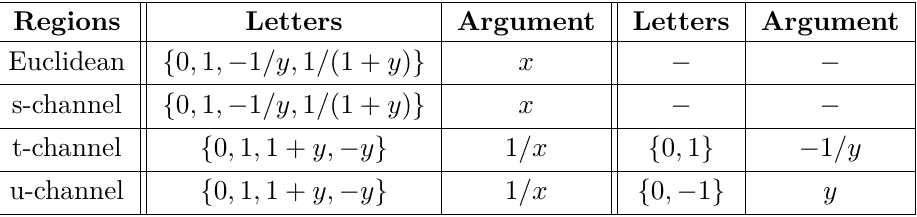
Table 1 . Structure of GPLs appearing in each of the 4 kinematic